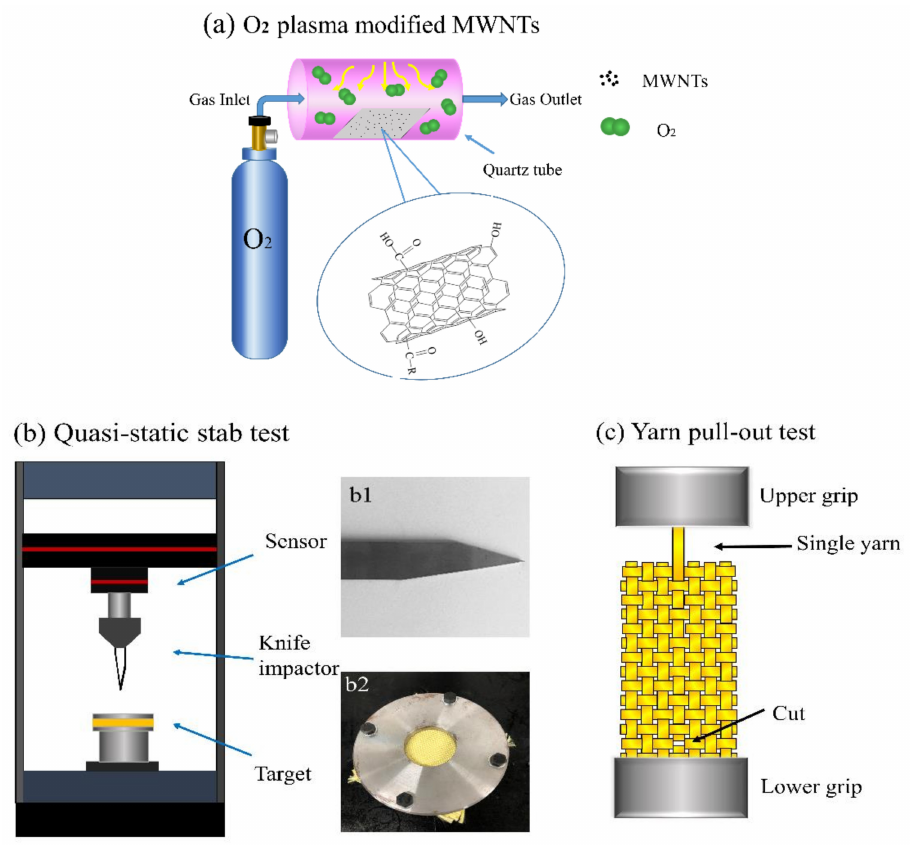
Figure 2. Schematic illustration of experimental equipment. ( a ) O 2 plasma modified MWNTs. ( b ) Quasi-static stab test, the knife blade P1 (b1) and matched to the fabrics clamper (b2), ( c ) Yarn pull-out